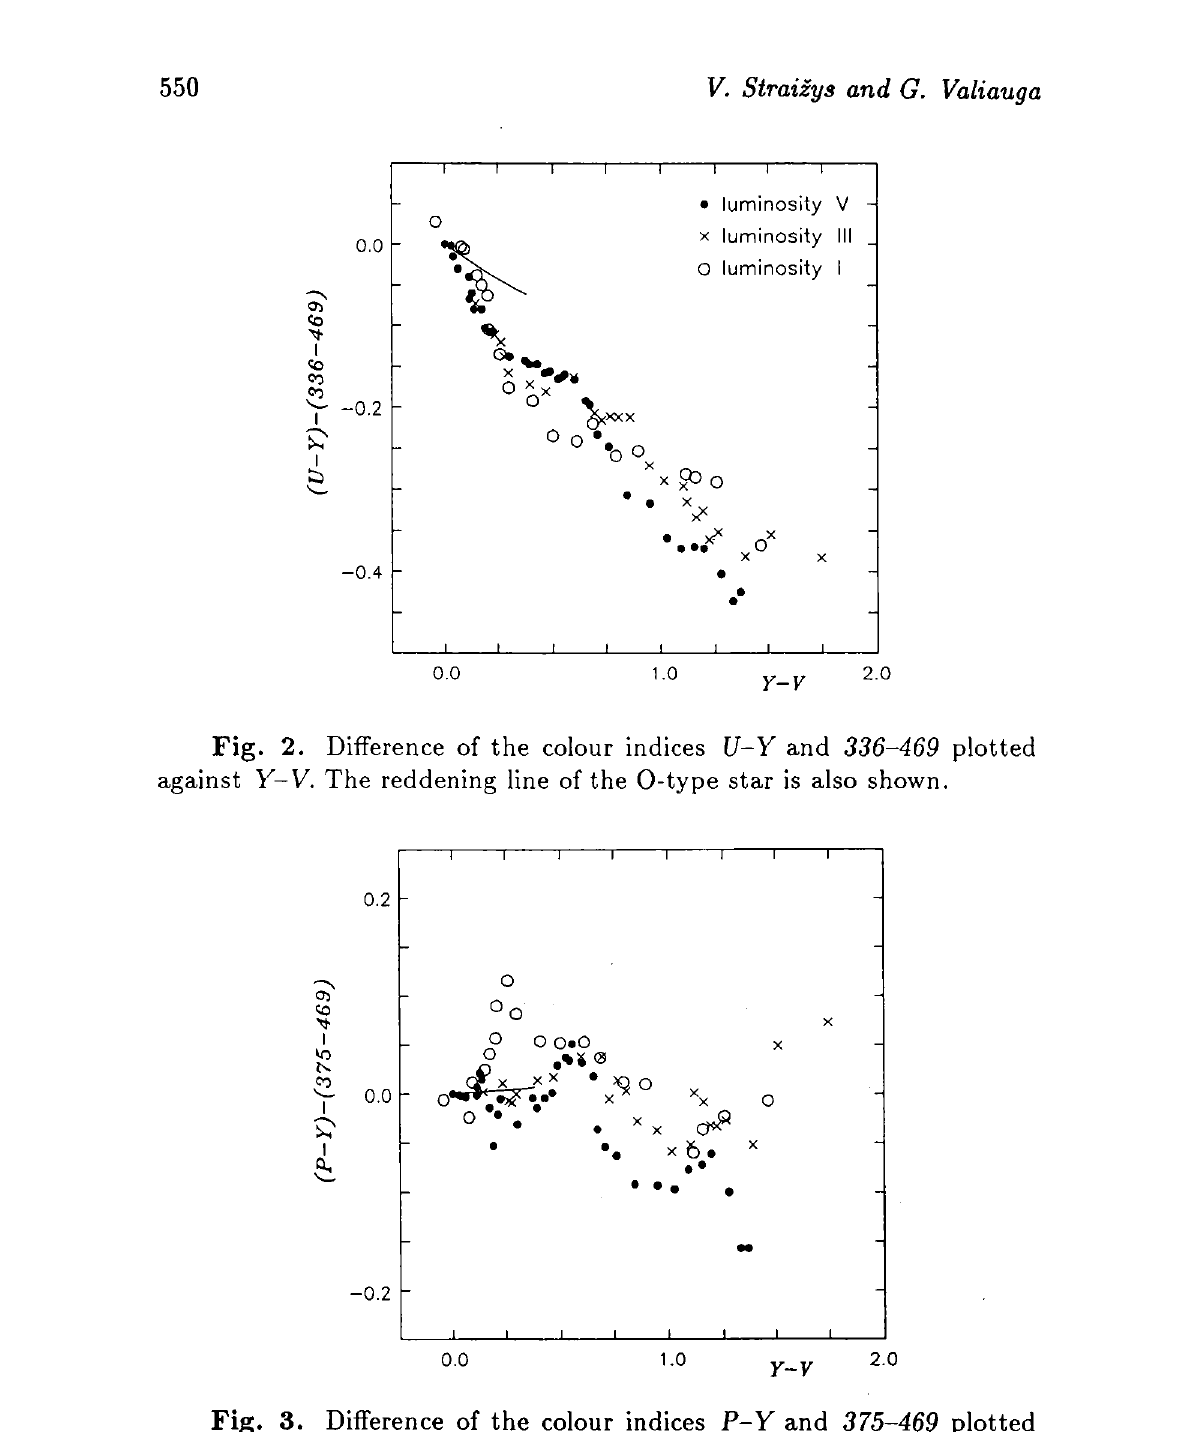
Fig. 3. Difference of the colour indices P-Y and 375-469 plotted against Y-V. The symbols are as in Fig.